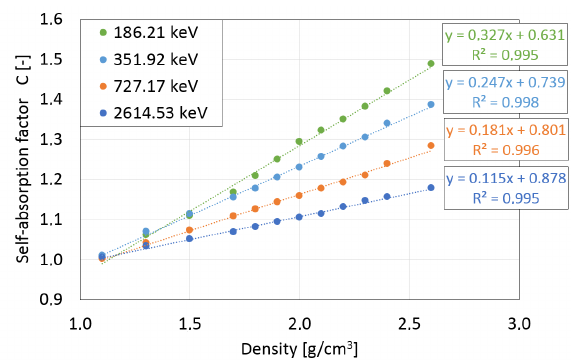
Figure 6. Correction factor for M600 as a function of photon energy.